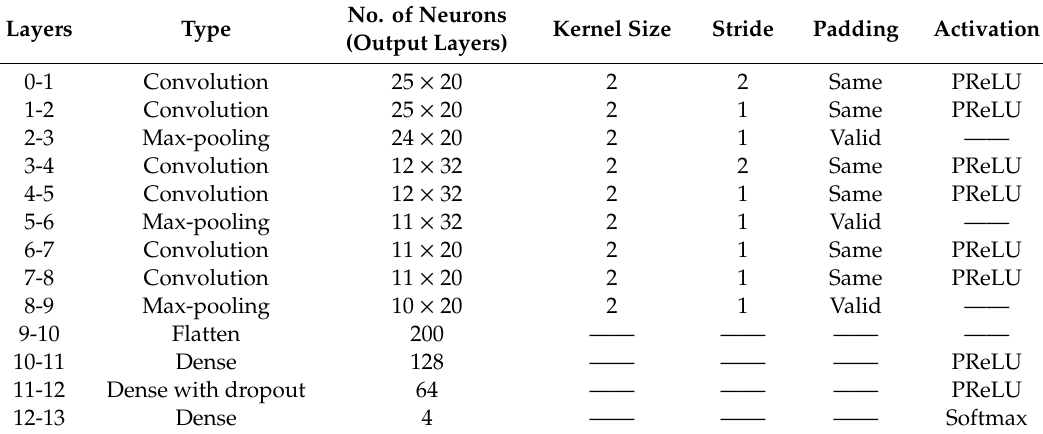
Table 2. The details of CNN structure.